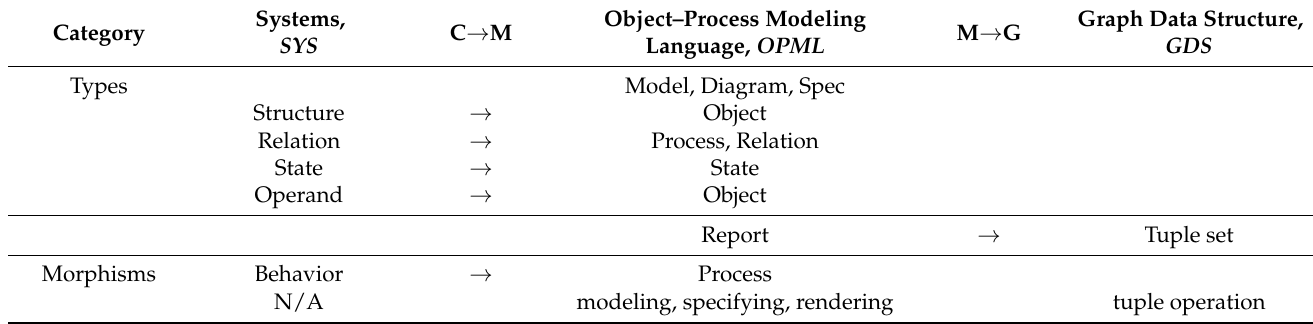
Figure 6. The OPM modeling language, OPML, as a category. Modeling (the morphism m ) is like hopping through the instantiation of category types based on existing artifacts. For example: (a) creating a new Diagram D1 in a Model M, (b) creating an Object Ob1 in D1, (c) creating a Process P1 in D1, (d) creating a RelationRr1(Ob1,P1) from Ob1 to P1, (e) creating a new Diagram D2 from P1, (f) adding States St11 and St12 to Ob1 in D2, and so on. Every instantiation of a type also affects the Spec, and therefore all graphical elements have a mapping into Spec (the morphism s ). Spec also feeds into the Rendering morphism r , which renders a Report from the Spec, currently in the form of a PDF file. Diagram created using MATLAB 2019b digraph plotting capabilities [85]. Table 4. Mapping the category of Systems, SYS , to a category of OPM models, OPML , and to a category of Graph Data Structures, GDS